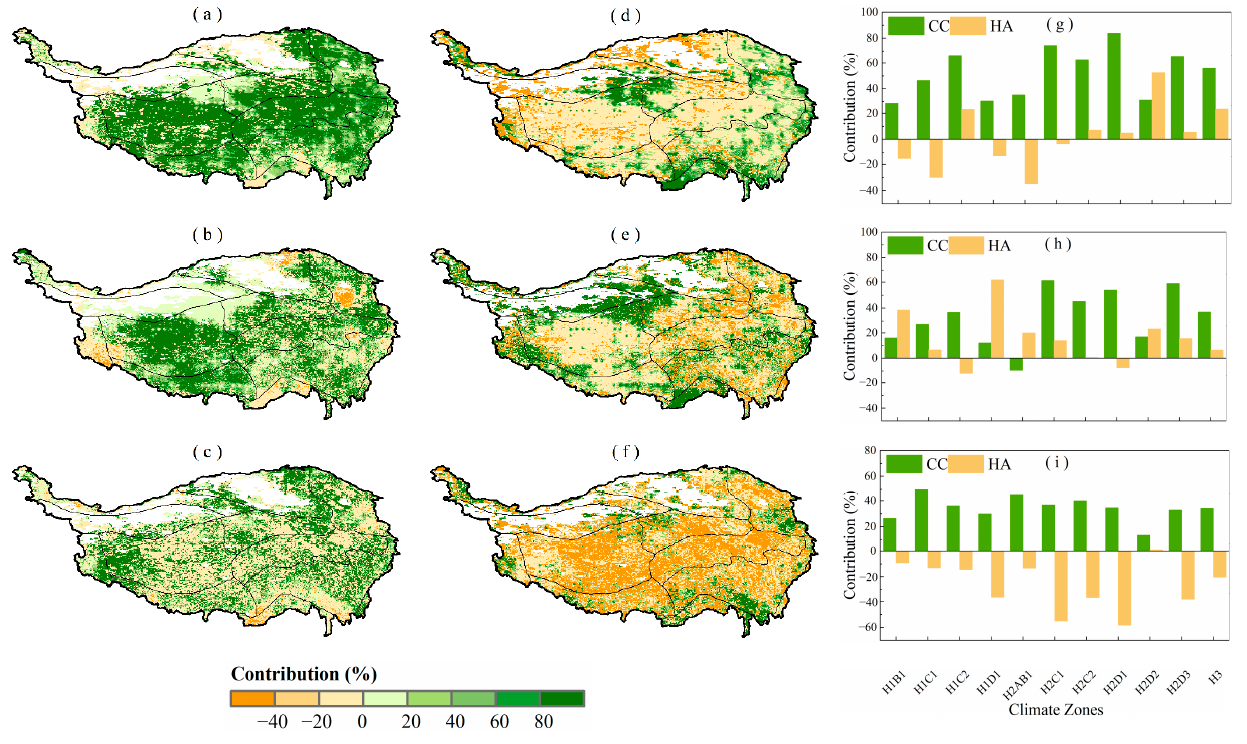
Figure 9. Spatial distribution of the contributions of climate change and human activities to vegetation